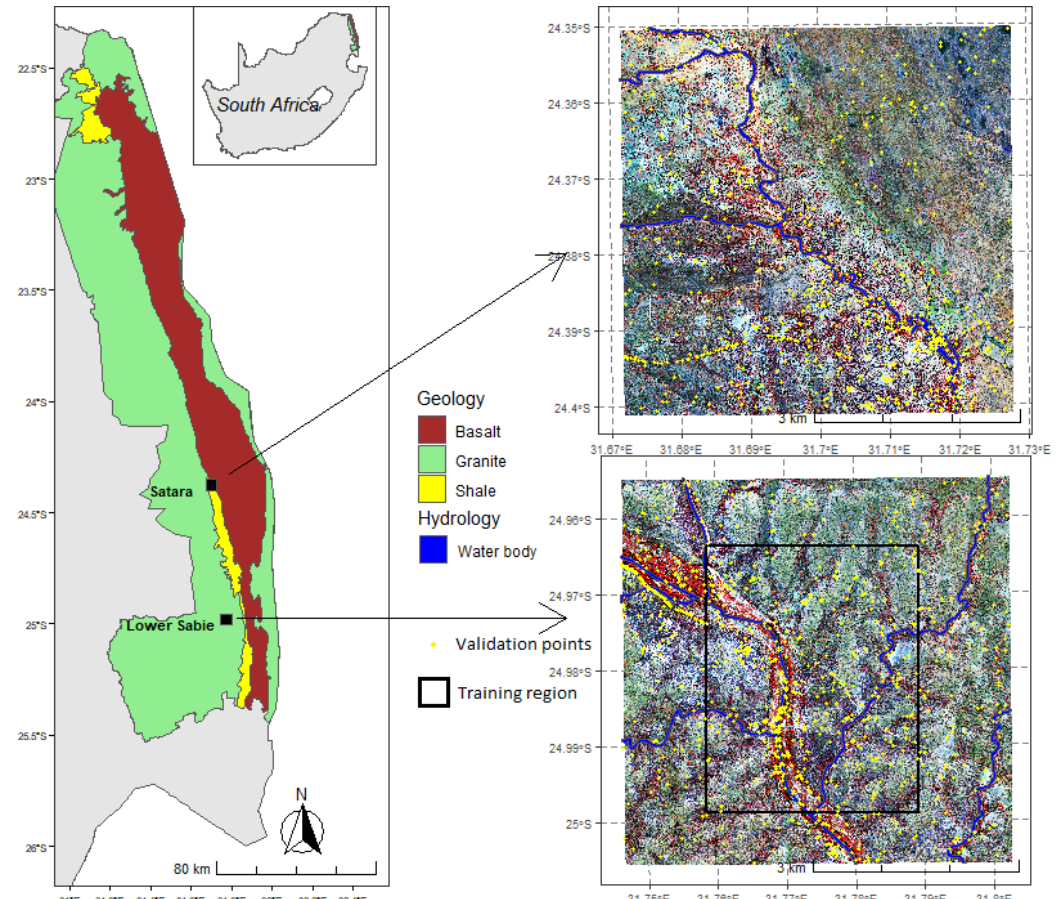
Figure 1. Map of study area showing locations of the Satara and Lower Sabie field sites in Kruger National Park (KNP), with enlarged views of the WorldView-3 satellite scenes (False colour: NIR1, R, G) overlaid with hydrology. Inset map shows the location of KNP within South Africa. Geological information was obtained from South African National Parks data